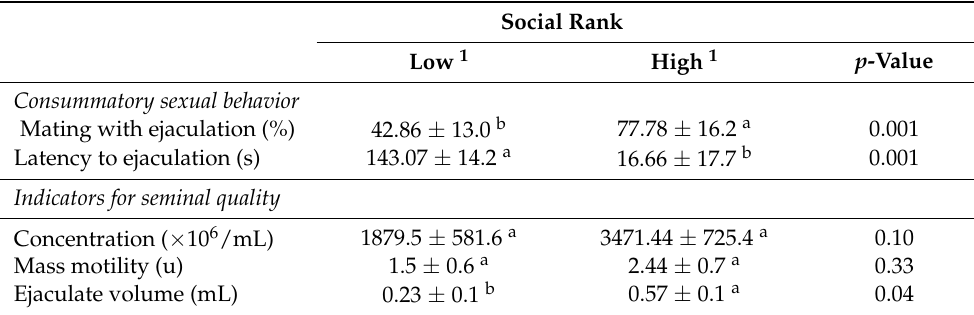
Table 5. Least square means ± standard error for the male-to-female actions during the early reproductive season (i.e., Sept) considering the variables of mating with ejaculation, latency to ejaculation, sperm concentration, mass motility, and ejaculate volume, according to either low ( n = 15) or high ( n = 9) social rank in Dorper rams ( n = 24) in northern Mexico (25 ◦ N) 1 . Social Rank Low 1 High 1 p -Value Consummatory sexual behavior Mating with ejaculation (%) 42.86 ± 13.0 b 77.78 ± 16.2 a 0.001 Latency to ejaculation (s) 143.07 ± 14.2 a 16.66 ± 17.7 b 0.001 Indicators for seminal quality Concentration ( × 10 6 /mL) 1879.5 ± 581.6 a 3471.44 ± 725.4 a 0.10 Mass motility (u) 1.5 ± 0.6 a 2.44 ± 0.7 a 0.33 Ejaculate volume (mL) 0.23 ± 0.1 b 0.57 ± 0.1 a 0.04